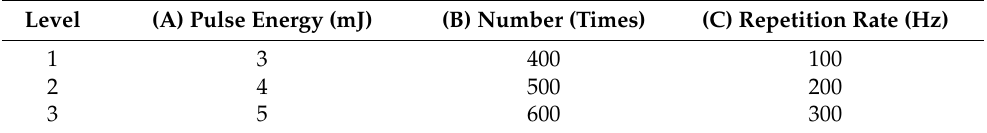
Table 2. The values and the labels of the three factors and three levels. For example, 3 mJ is labeled as A1.